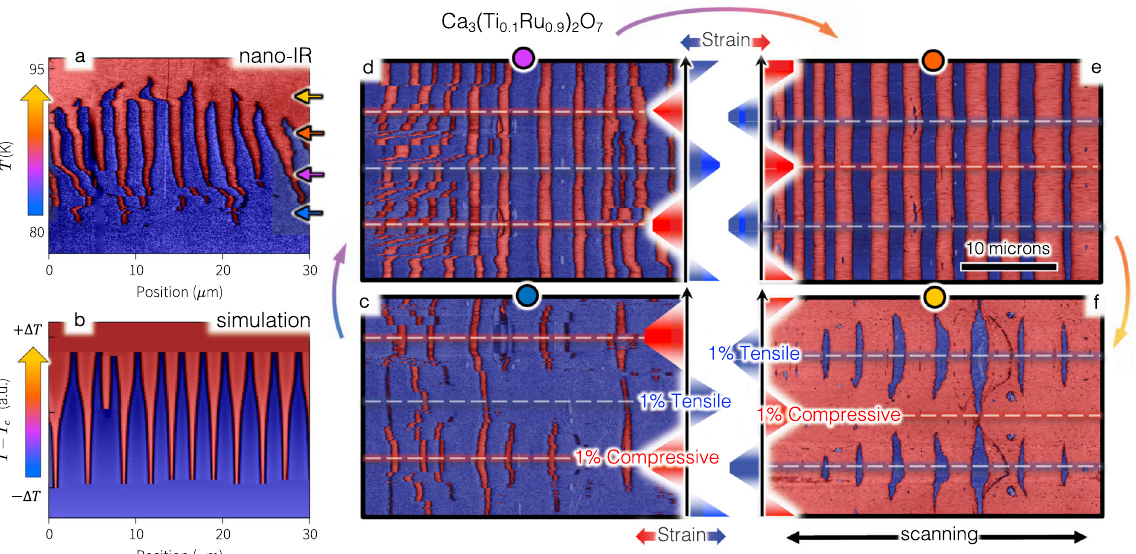
Fig. 3 Scanning nano-susceptibility of temperature- and strain-tuned Mott domains. a Repeated nano-imaging along a fi xed-line parallel to the b -axis of a 300 micron-long rectangular crystal while linearly warming the sample temperature resolves thermal evolution of domain textures. b A phase- fi eld simulation of a strain-coupled transition (see text) replicates the observed domain evolution. c – f Repeated nano- imaging along the same line as ( a ) but at fi xed temperatures, identi fi ed by colored circles associated with arrows in ( a ), and under programmable strain-sweeps. c At low temperature compressive strain nucleates metallic stripes; f at high temperature tensile strain nucleates insulating stripes; d , e intermediate temperatures alternatively reveal rigidity or complex rearrangement of domain